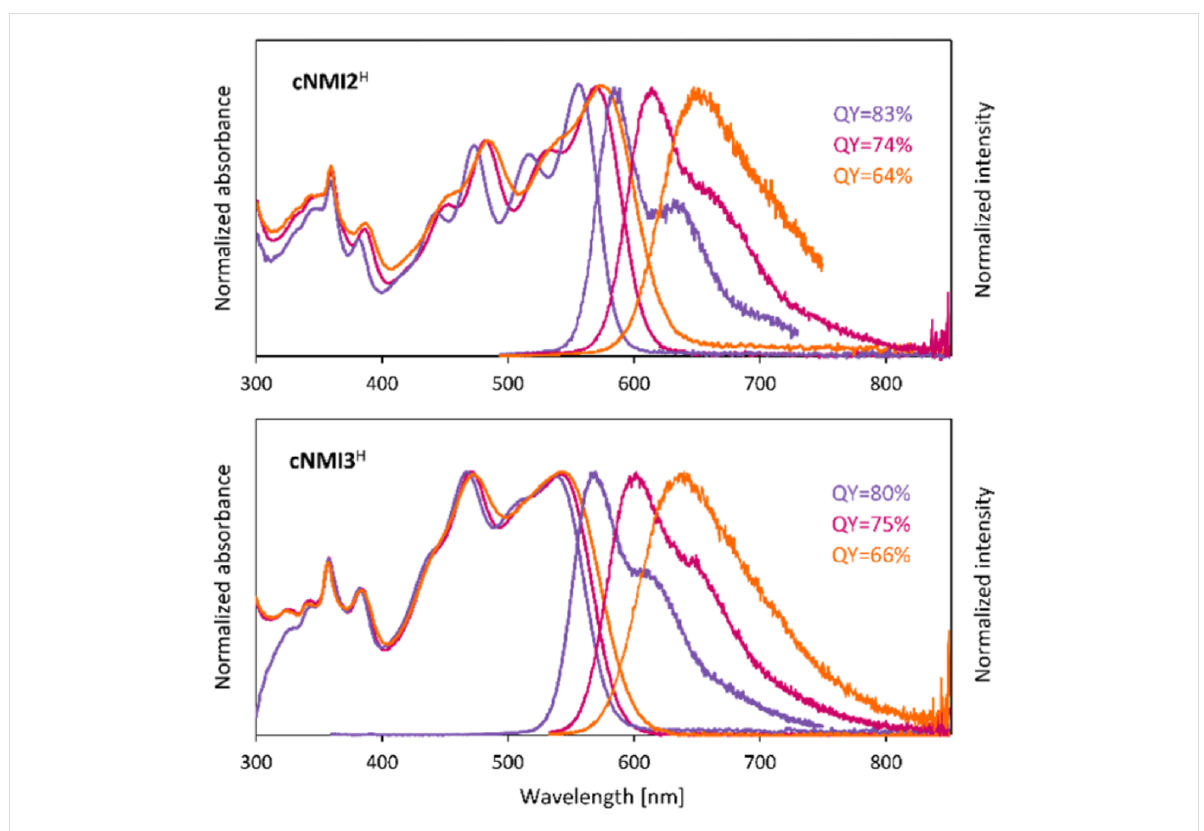
Figure 2: Absorption and emission spectra of cNMI2 H (top) and cNMI3 H (bottom) measured in toluene, dichloromethane and acetonitrile.